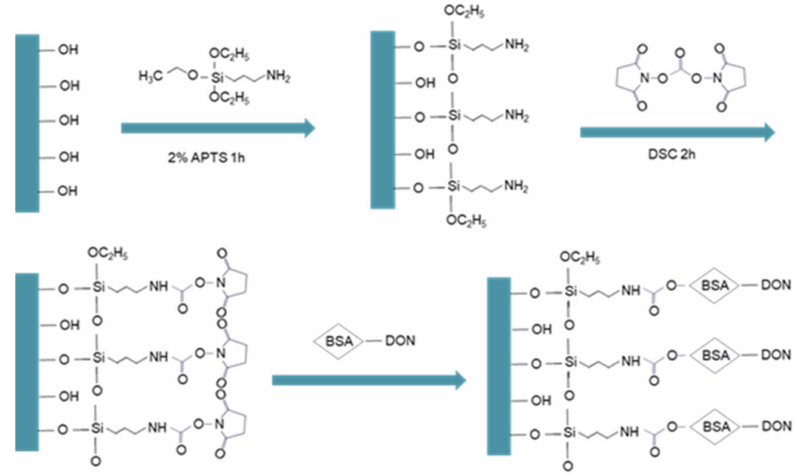
Figure 2. Preparation of the fiber optic bio-probe. DON-BSA conjugates were covalently modified on the aminated bio-probe surface using DSC as the bifunctional